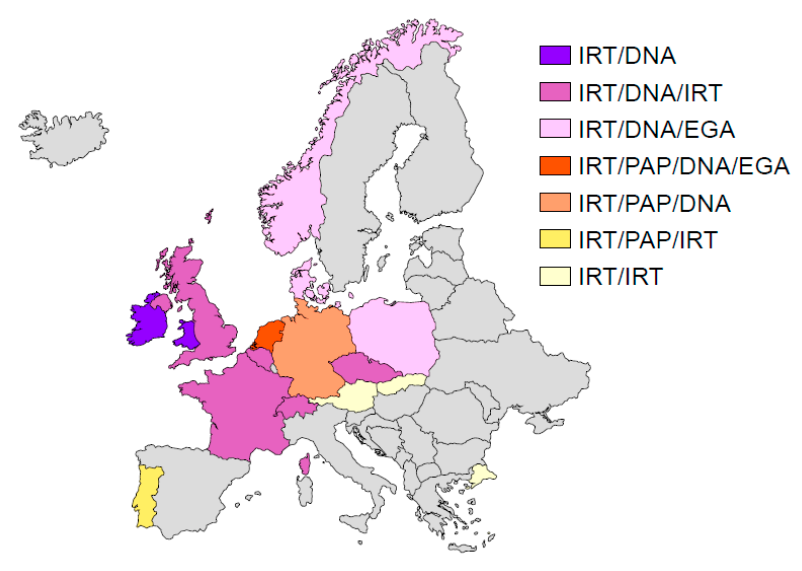
Figure 7. Protocols used in newborn screening for cystic fibrosis in Europe in 2020. Abbreviations include IRT—immunoreactive trypsinogen; EGA—expanded or extended gene analysis; PAP—pancreatitis-associated protein.